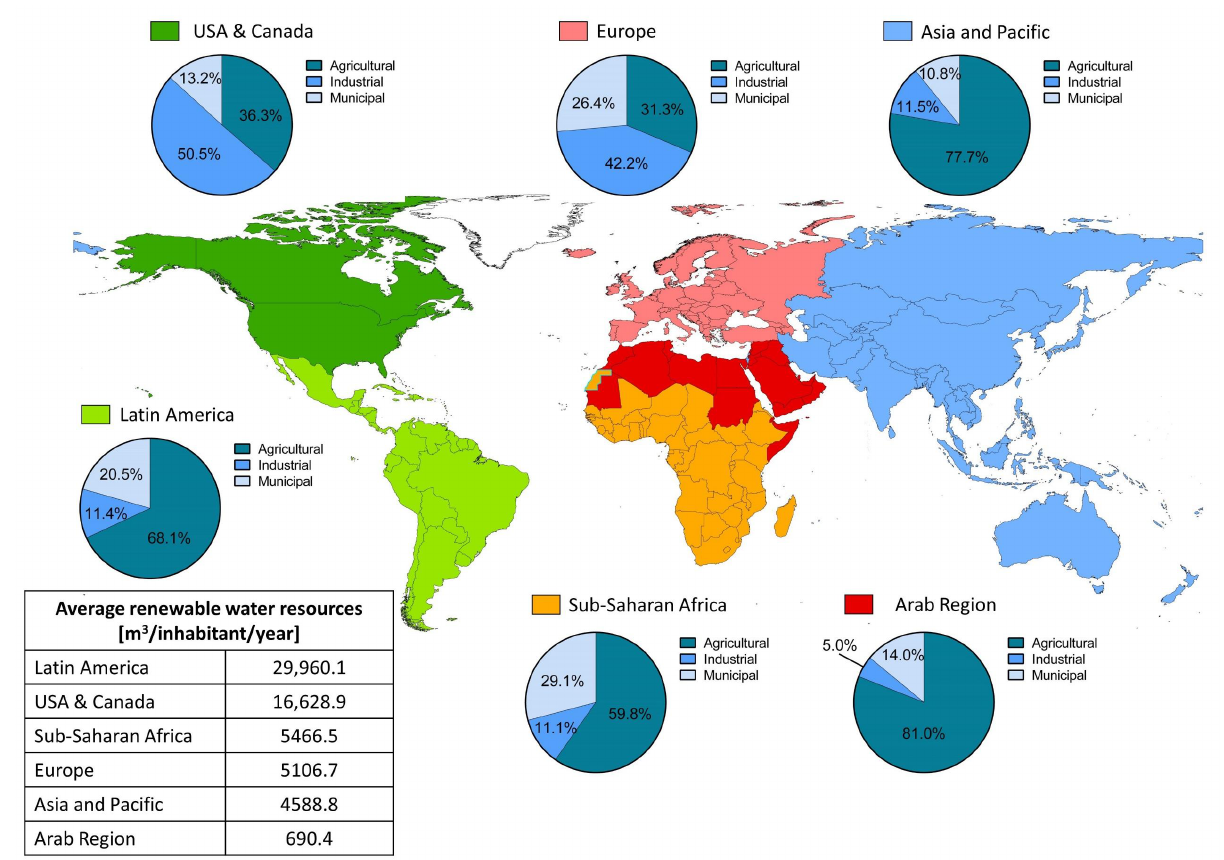
Figure 1. Water use by activity in the world. Source: Aquastat database [7].